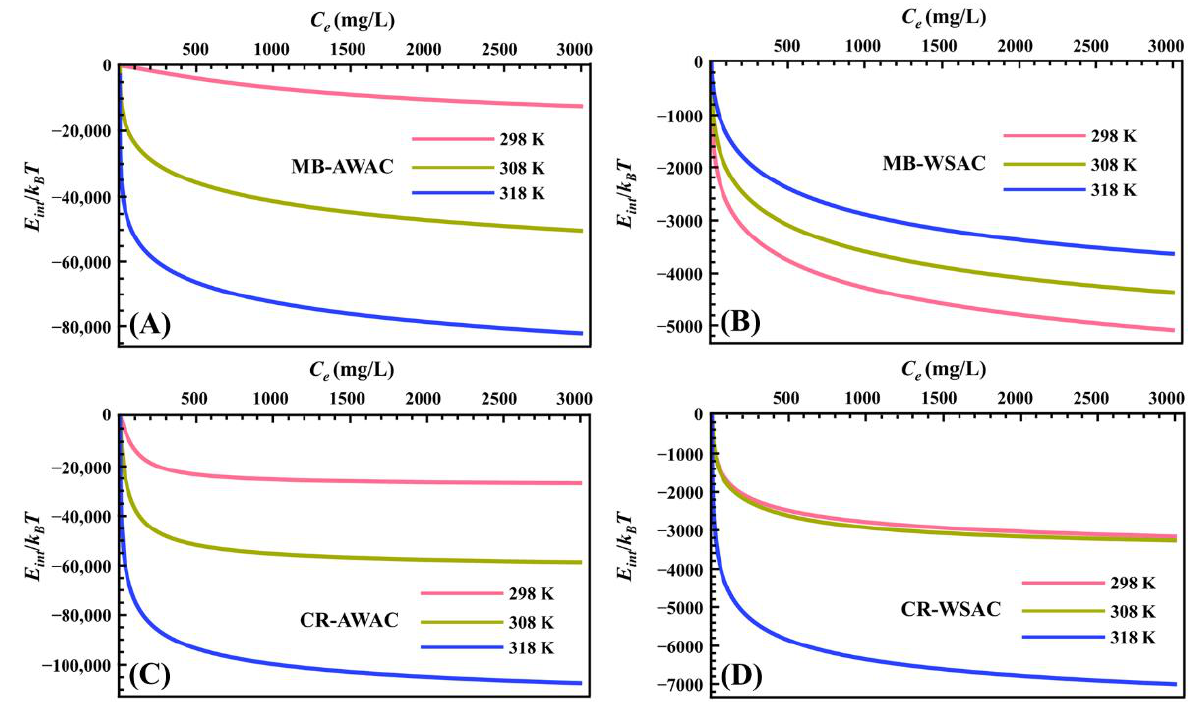
Figure 4. Internal energy ( E int ) evolution with dye concentration for MB-AWAC ( A ), MB-WSAC ( B ), CR-AWAC ( C ), and CR-WSAC ( D ) adsorption systems.